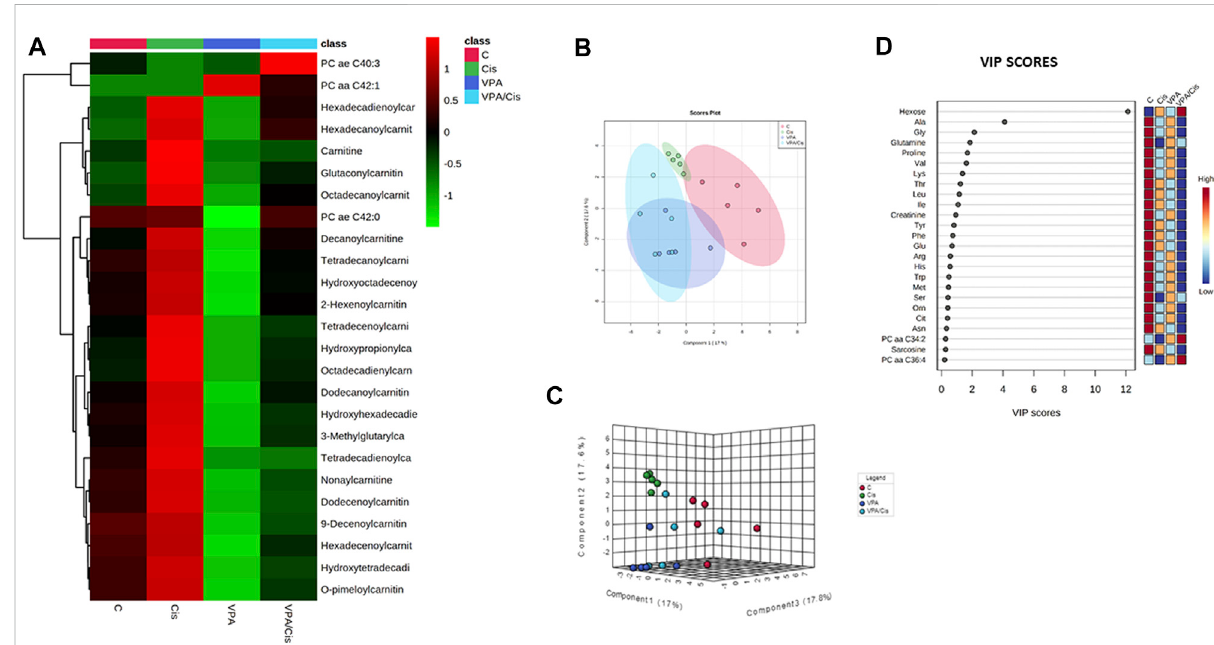
FIGURE 1 MetabolicanalysisofVPA,Cisplatin,theircombinationandcontrol(untreated)MDA-MB-231cellsafter72 hoftreatment. (A) Heatmapshowing the 25 metabolites most in fl uenced by the treatments. (B) PLS-DA supervised score plot. (C) 3D supervised PLS-DA score plot. (D) VIP score plot. From each condition, n = 5 replicates were